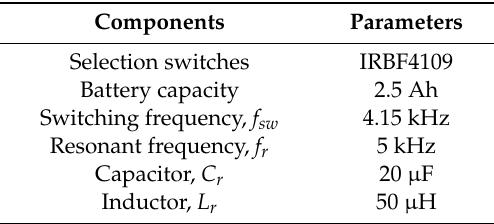
Table 2. Battery voltages during offline balancing.